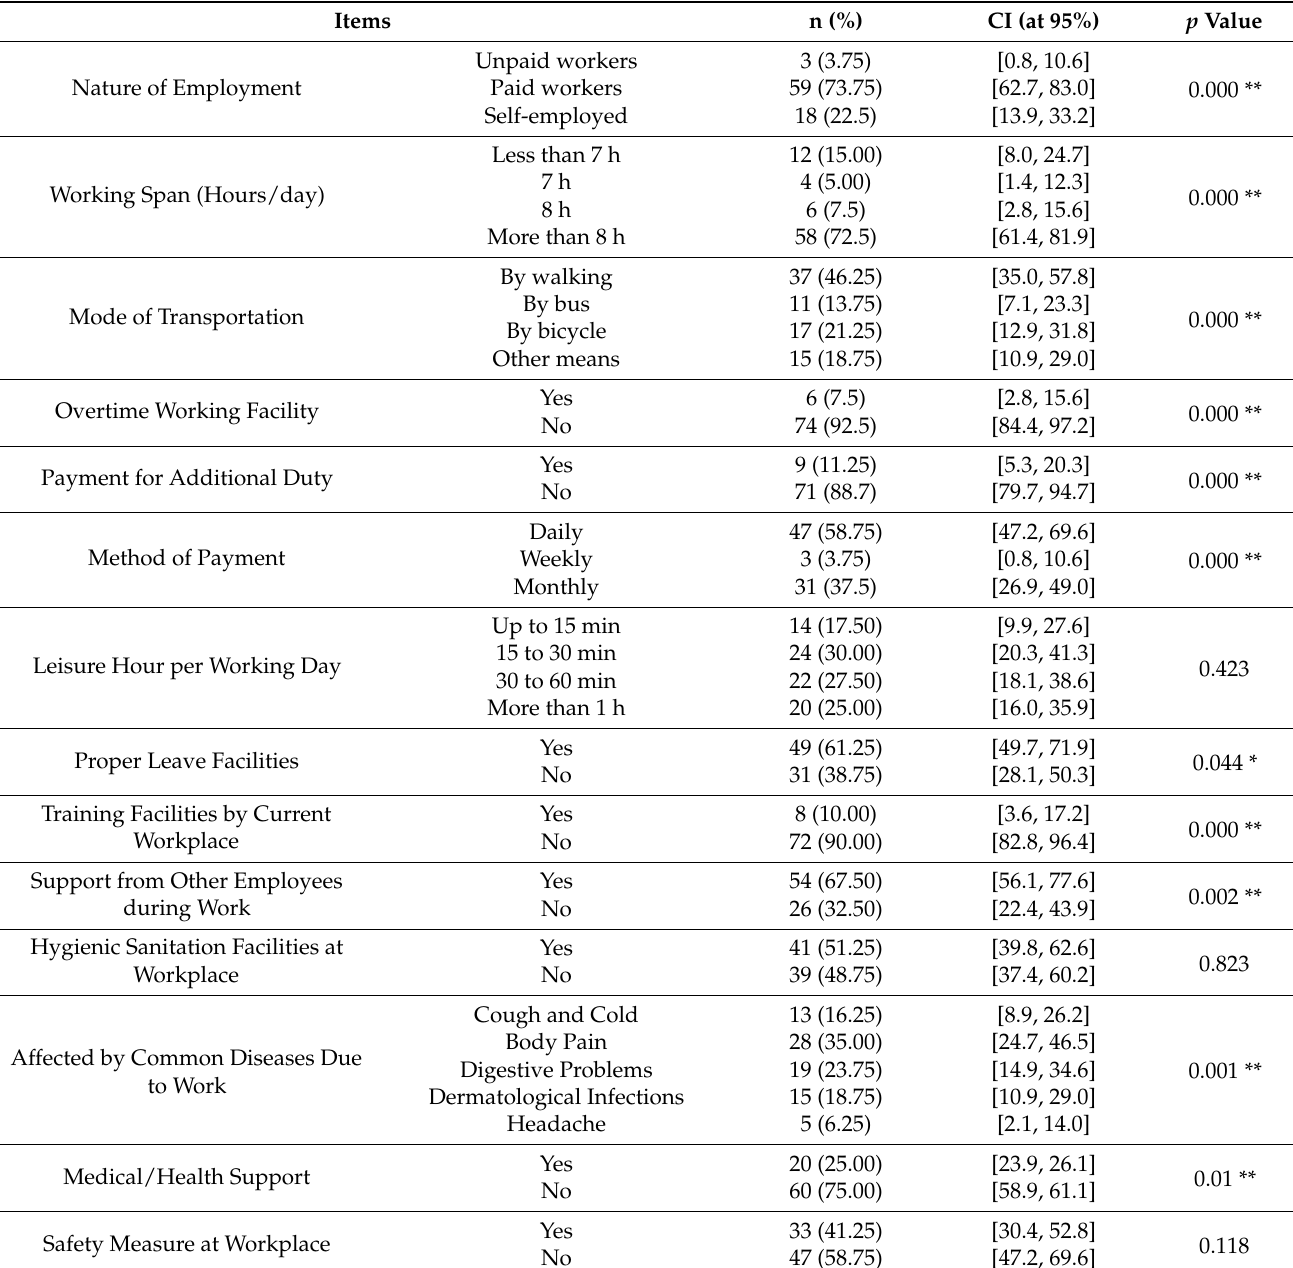
Table 4. Nature of Employment and Working